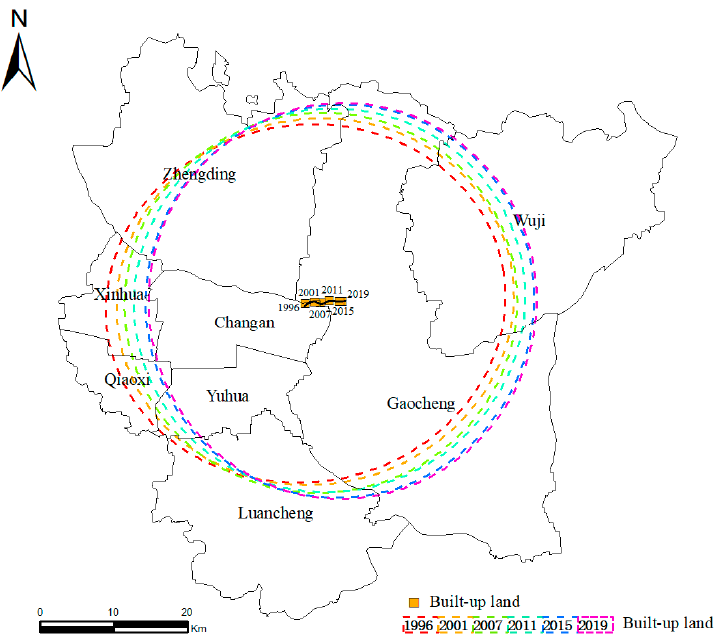
Figure 6. Evolution of center points and standard deviation ellipse (SDE) of the urban heat island (UHI) of the study area from 1996 to 2019.